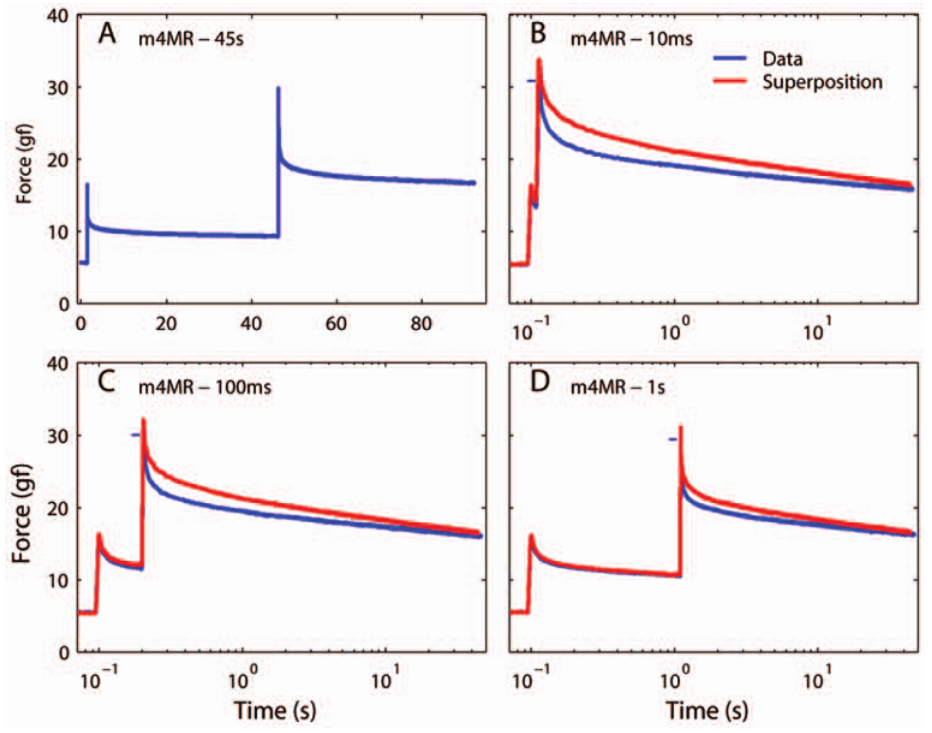
Figure 11. Testing the superposition hypothesis in muscle at long lengths. A : A sequence of two elongation steps (0.5 mm each), separated in time (ISI) by 45 s, was applied, and the resulting force measured. B : The same two steps shown in A are applied, but now the ISI is only 10 ms. (Blue: Force measured. Red: Force predicted by the superposition principle) C : Same as in B, but with an ISI of 100 ms. D : Same as in C, but with an ISI of 1 s. For clarity, the maximum force recorded is marked by a small horizontal blue bar just to the left of the value. In all cases the prediction is initially considerably higher than the actual force, indicating that the superposition principle does not hold in muscle at long lengths.